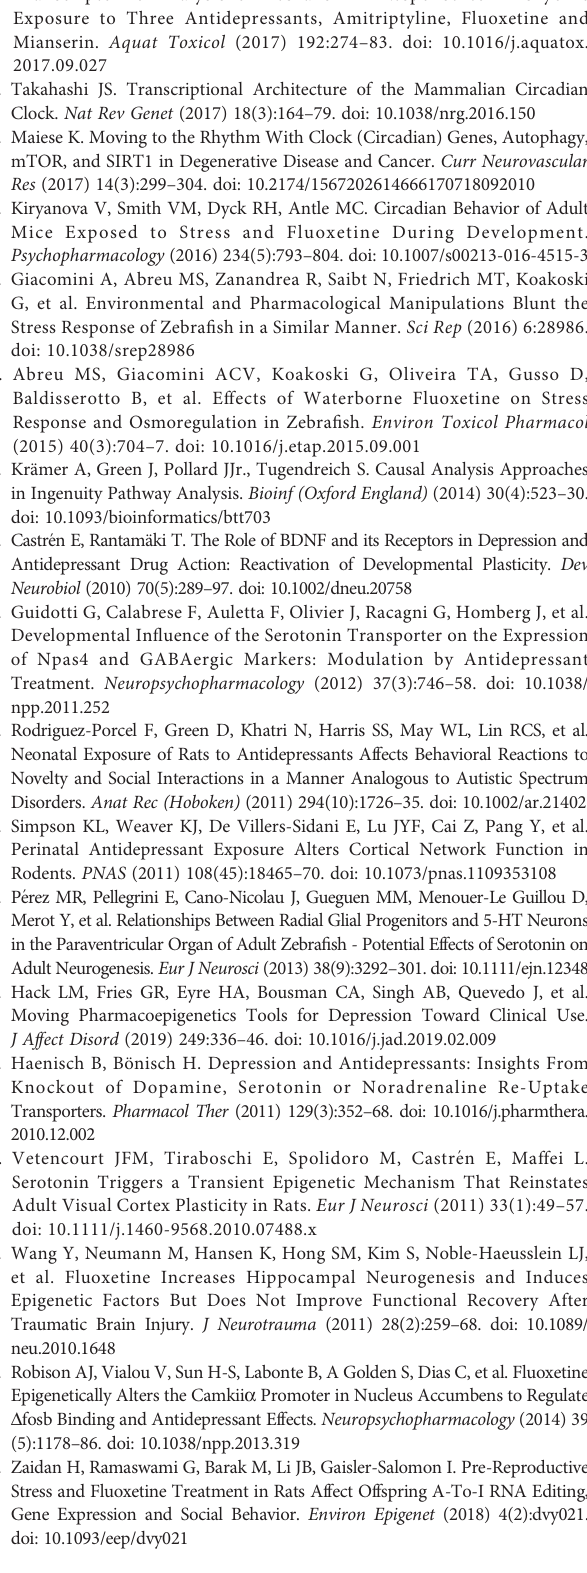
Figueiredo RM, Winter P, et al. Advancing Brain Barriers RNA Sequencing: Guidelines From Experimental Design to